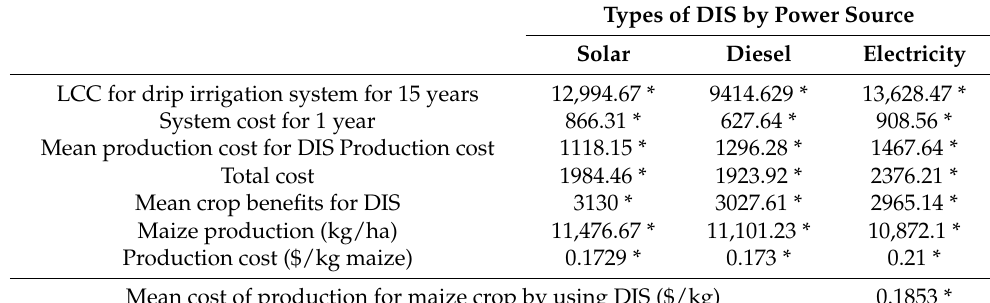
Table 5. Cost comparison of different power sources for